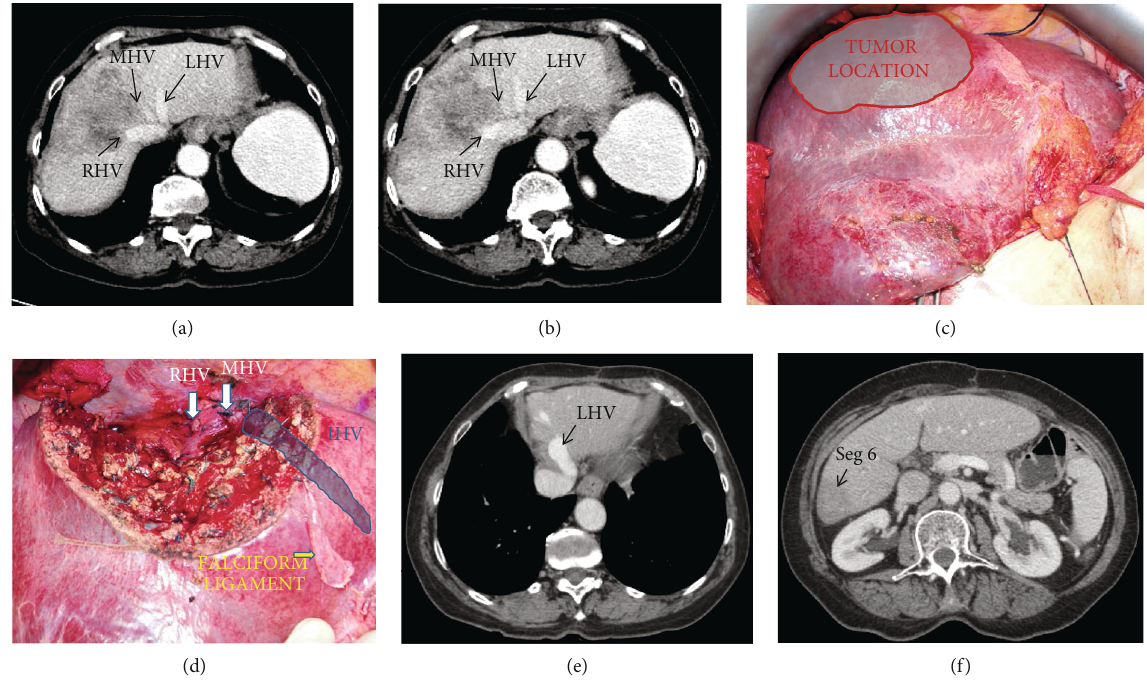
Figure 4: (Patient 3) (a, b) Colorectal liver metastasis with right and middle hepatic vein invasion. (c) Intraoperative aspect of the liver and tumor location. (d) Immediate postoperative aspects of the liver, distal right, and middle hepatic vein ligated at the vena cava con fl uence. (e) Left hepatic vein draining remnant liver segments. (f) Postoperative segment 6 atrophy.